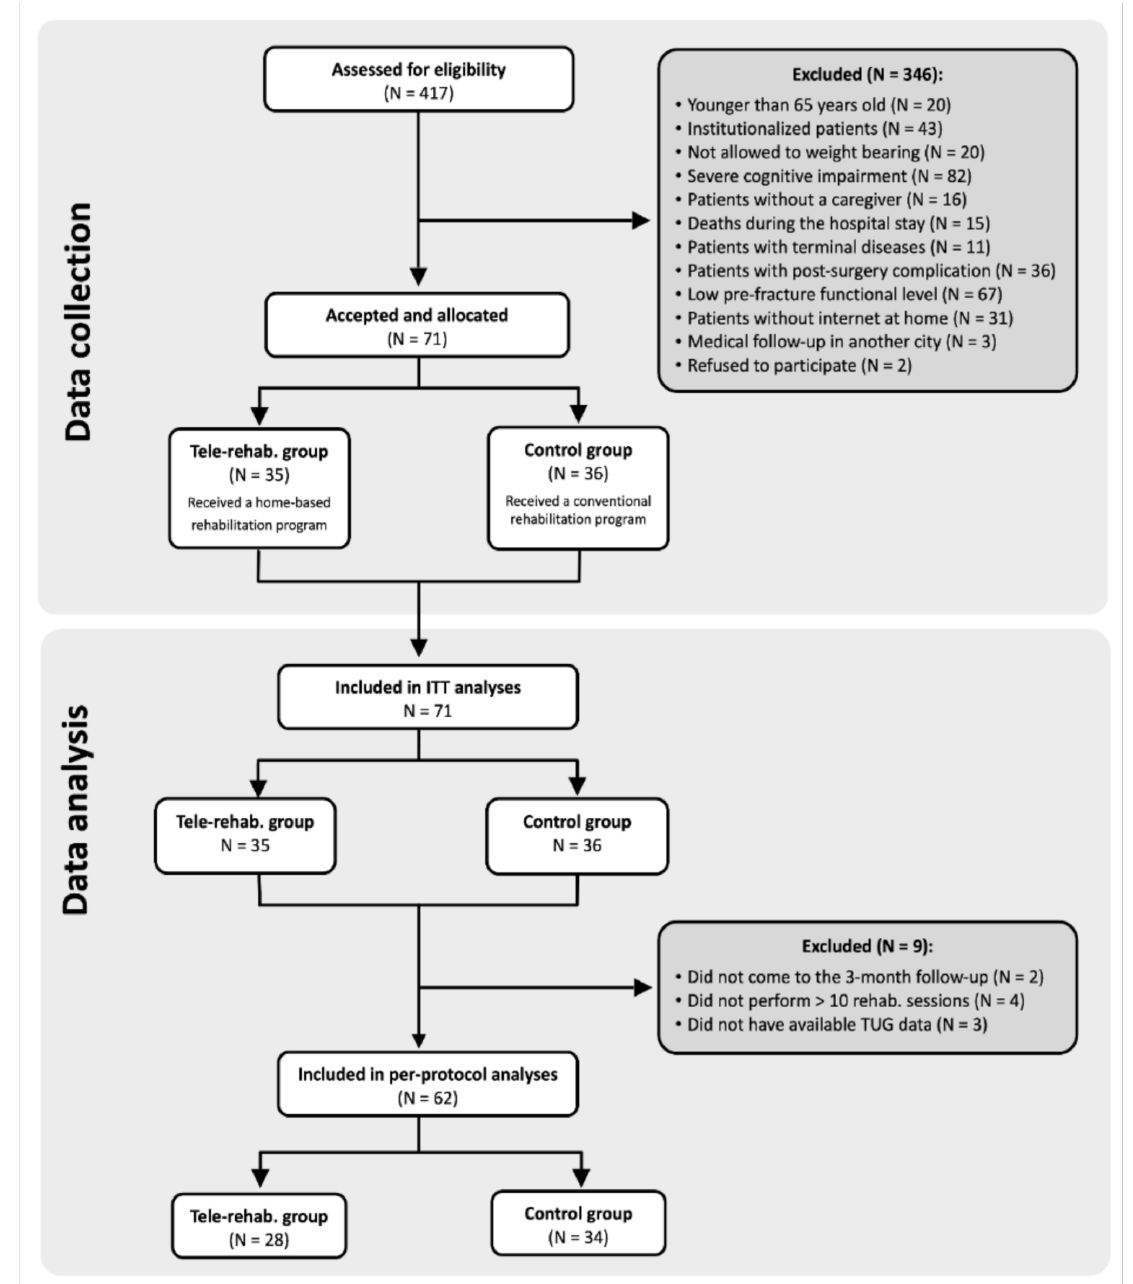
Figure 1. Flowchart with the inclusion/exclusion of